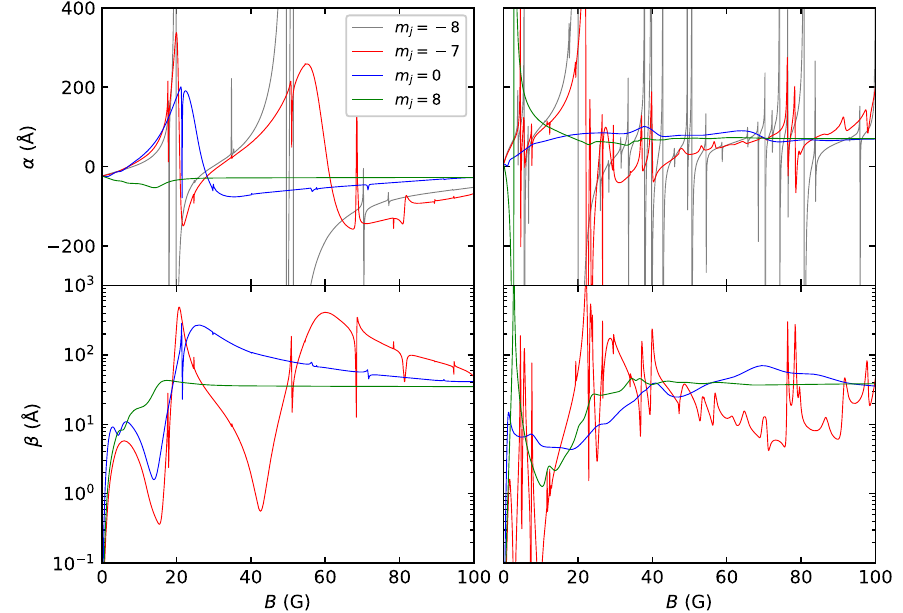
FIG. 3. Complex scattering lengths a ¼ α − i β as a function of the magnetic field for Dy þ Yb with Dy in excited Zeeman states − 7 (red lines), 0 (blue lines), and 8 (green lines); m m j ¼ potential with long-range anisotropy C ð described in the